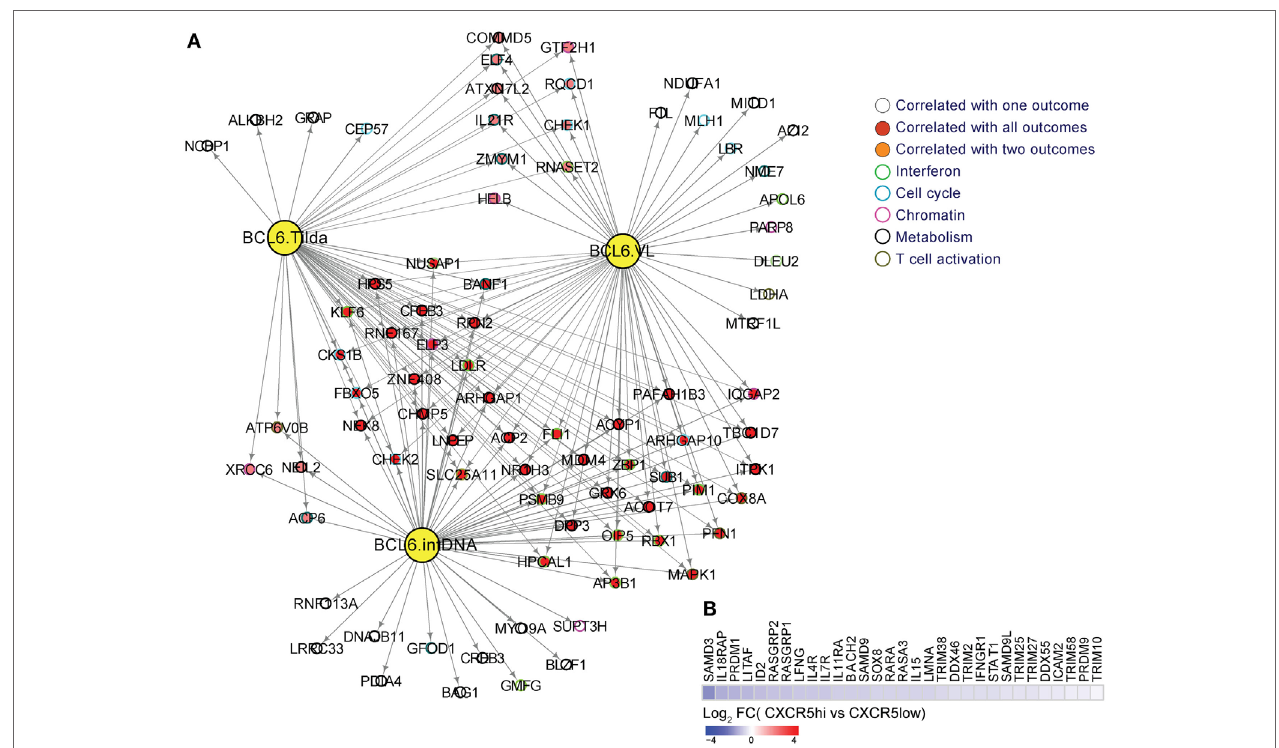
FIGURE 2 | (A) BCL-6 target genes are enriched in genes from interferon, metabolism, T cell activation and differentiation, cell cycle, and chromatin regulators pathways. A linear regression model to correlate BCL-6 targets to viral load, integrated DNA, and inducible RNA (TILDA) from a cohort of viremic subjects was performed using R. BCL-6 targets correlated significantly to viral load, integrated DNA and TILDA ( p -value < 0.05) were used to infer a gene-interacting network using Cytoscape. Yellow nodes represent BCL-6 targets correlated respectively to intDNA, TILDA, and viral loads. Red nodes represent genes correlated to viral load, integrated DNA, and TILDA, orange nodes represent genes correlated to two pathways and white nodes represent genes specific to each outcome. Circles color depict the different molecular functions enriched in these genes; (B) downregulation of restriction factors and genes involved in interferon type 1 signaling in CXCRS high vs. CXCR5 low cells from TFH cells from HIV − donors in LNs. Heatmap representing the gene log 2 -fold change expression ranging from blue ( down regulation) to red (